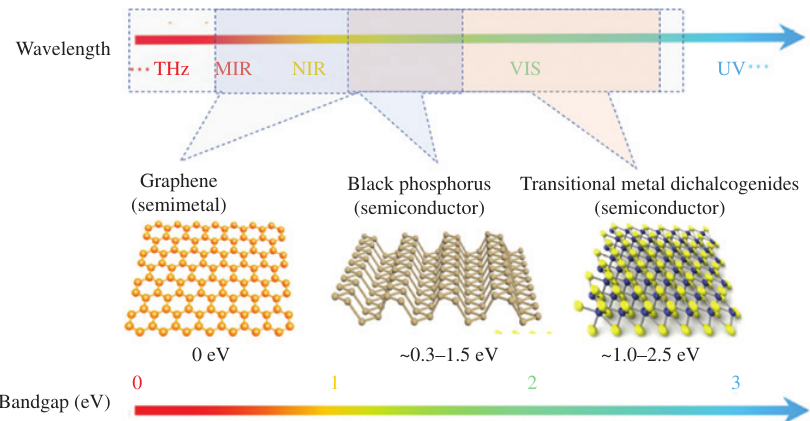
Figure 1: Optical response and electronic bandgaps of typical 2D materials. Intrinsic graphene is a zero-bandgap semimetal with optical response covering from THz to visible parts. TMDs have layer-dependent bandgap ranging from 0.3 eV to 1.5 eV. Black phosphorus shows direct bandgap of 1.0 eV to 2.5 eV depending on the thickness. Adapted from [13], Reproduced with permission [28]. Copyright 2017,